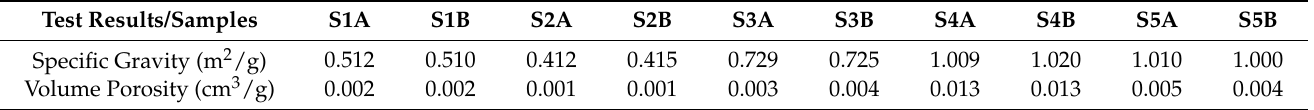
Table 4. Specific gravity and porosity results of the tested aggregates.